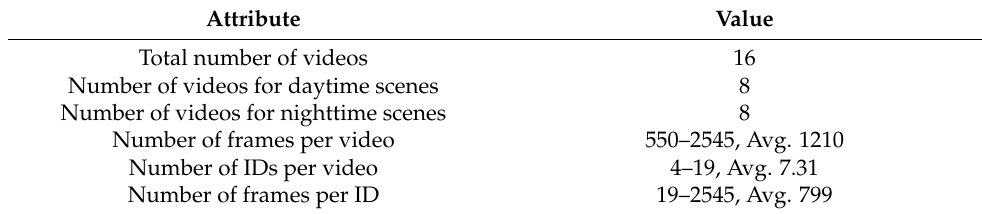
Table 2. The attributes of the vehicle tracking dataset.